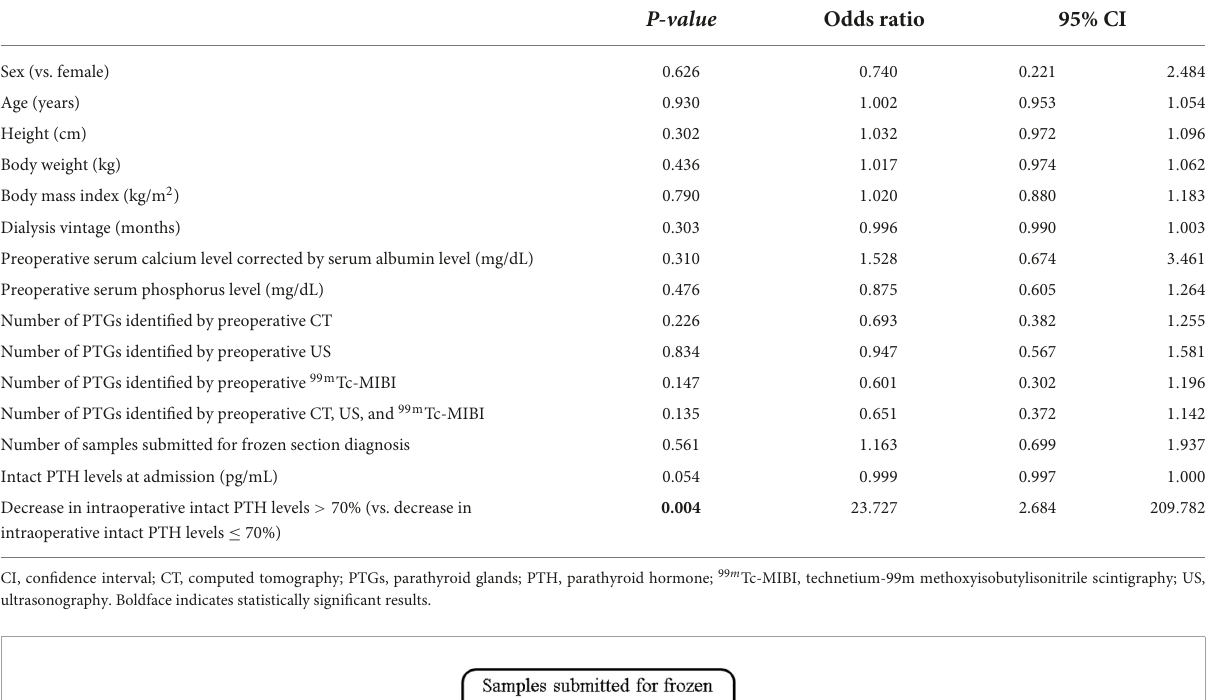
TABLE 6 Univariate logistic regression analysis for successful parathyroidectomy in patients with < 4 parathyroid glands identified by frozen section diagnosis. Sex (vs. female) 0.626